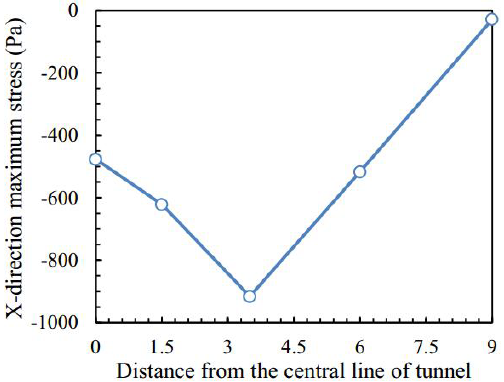
Figure 4. Variations of x -direction maximum stress at different lo- cations.